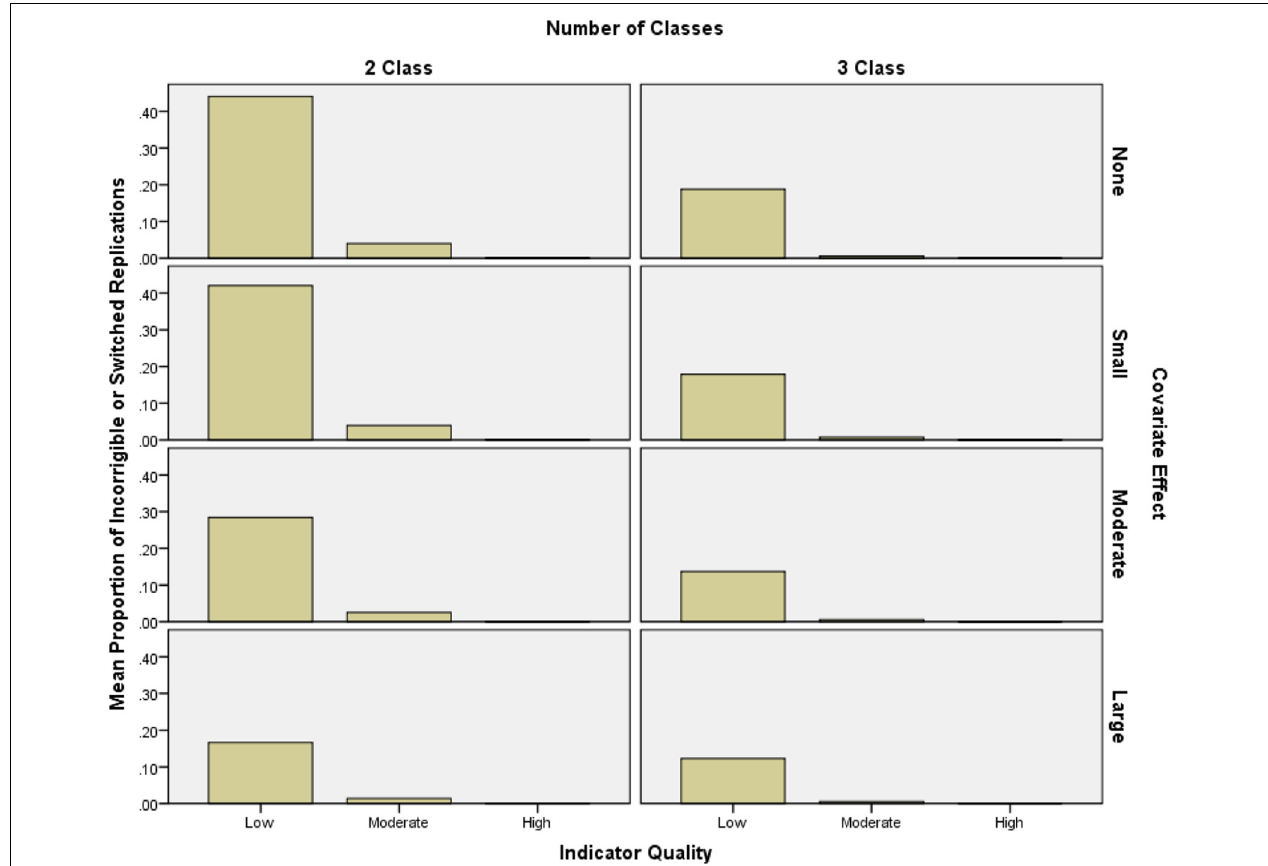
FIGURE 2 | Mean proportion of incorrigible replications per condition by indicator quality and covariate effect